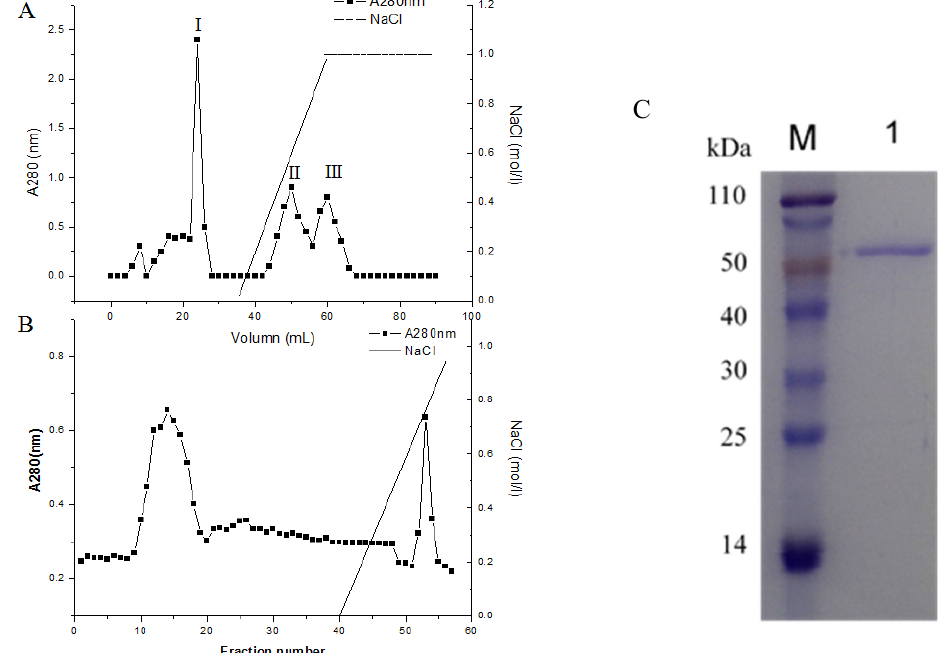
Figure 3. PpBXL purification process: ( A ) SP Fast Flow chromatography, ( B ) DEAE Fast Flow chro- matography and ( C ) SDS-PAGE of the purified PpBXL.